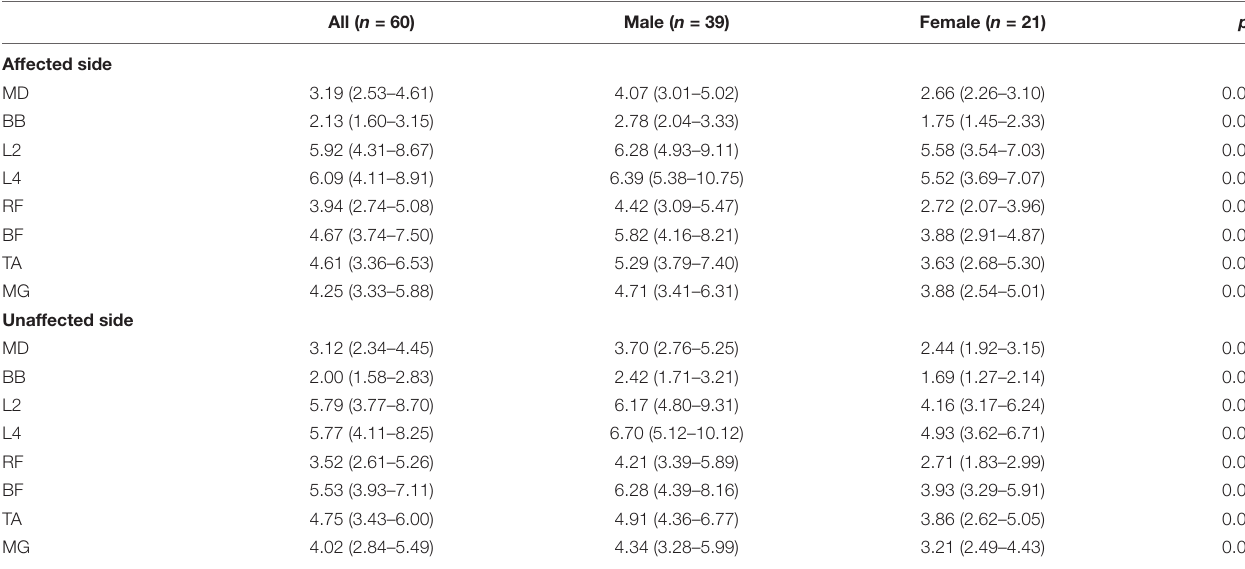
TABLE 2 | Absolute pressure pain thresholds in all patients